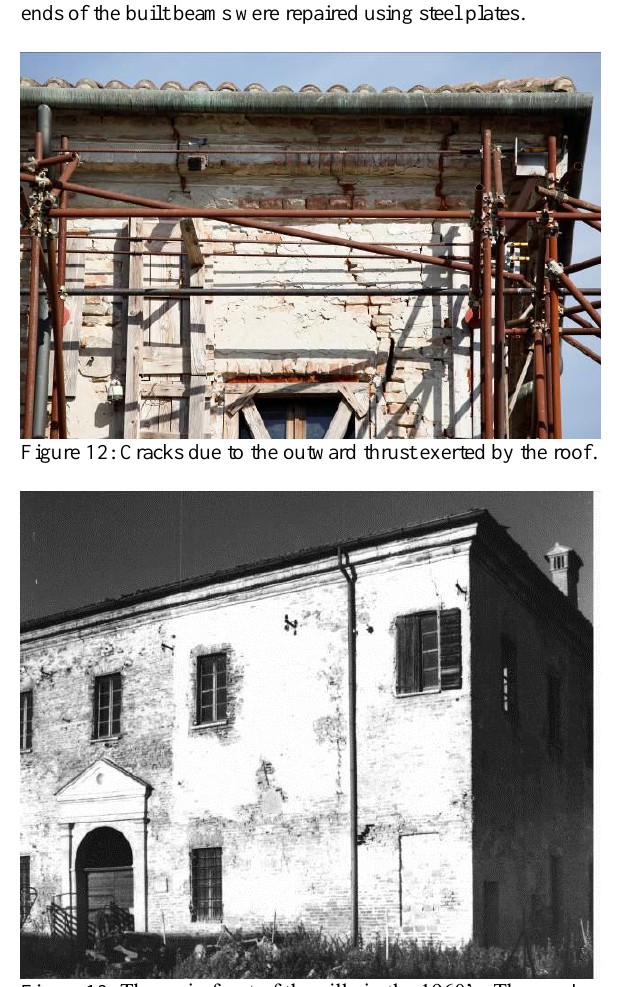
Figure 13: The main front of the villa in the 1960’s. The crack due to the outward thrust exerted by the roof can be seen in the upper right corner (Private archive Alberto Ferrari).